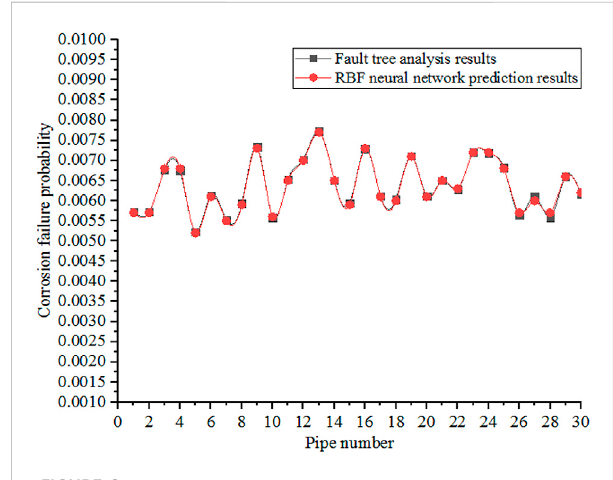
FIGURE 6 Comparison diagram of corrosion failure probability results of buried gathering and transmission